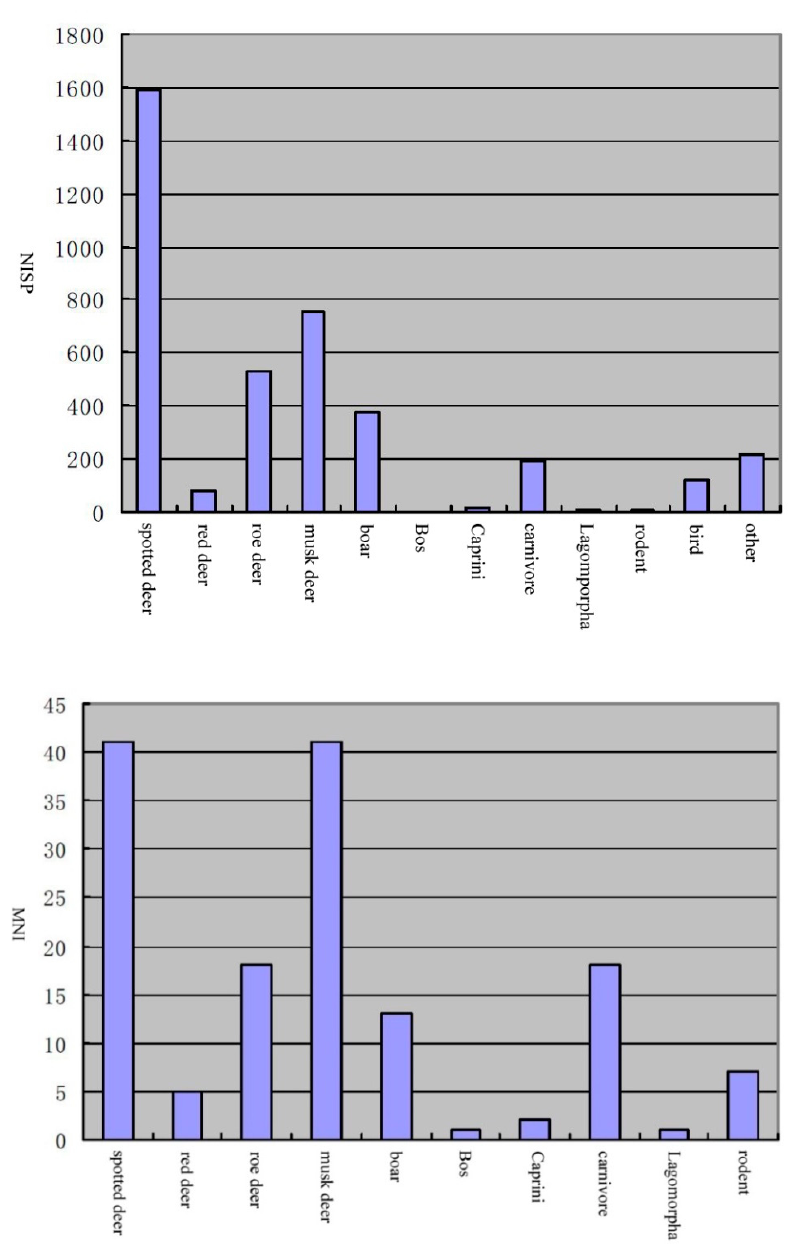
Figure 13. Number of identified specimens (NISPs) and minimal number of individuals (MNIs) of fauna at the Donghulin site (permission from Dr. Tian–Xing Cui).